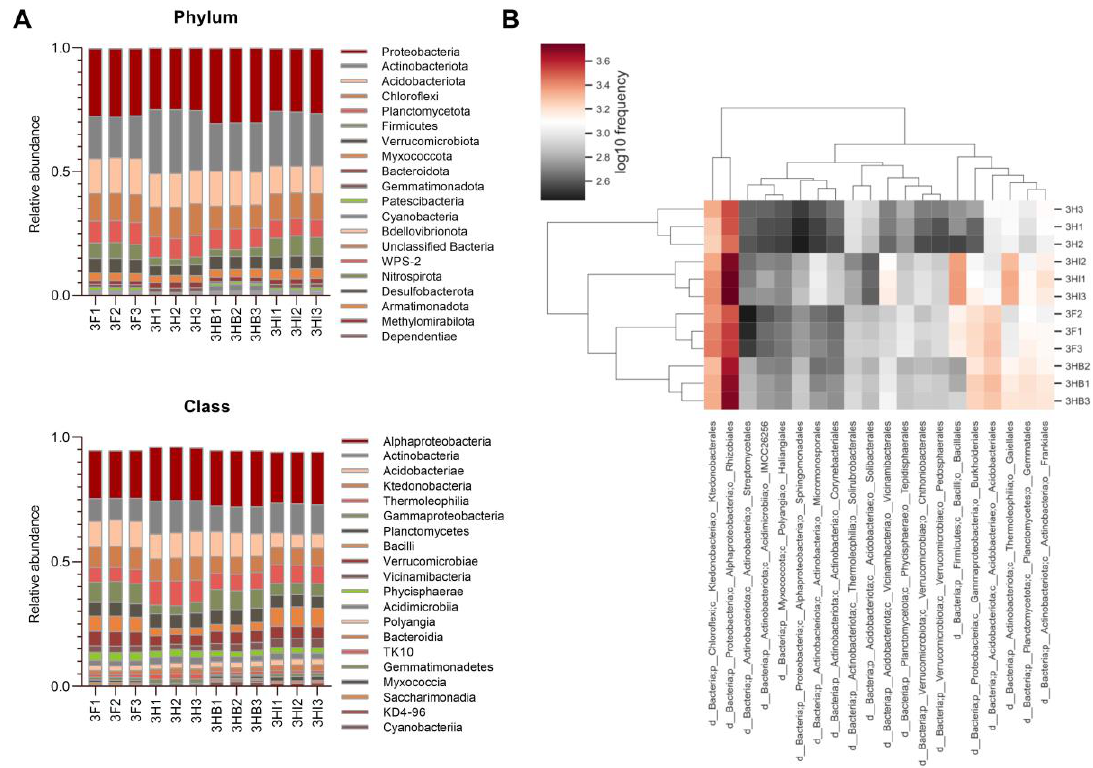
Figure 7. Relative abundance of the top 20 bacterial taxa at phylum and class level ( A ) and normalized heatmap analysis of the top 20 bacterial orders ( B ) of soil samples between four different treatment groups.